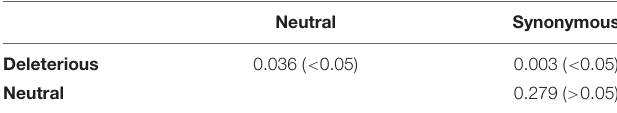
TABLE 5 | Results of the Wilcoxon rank sum test for mutation frequencies